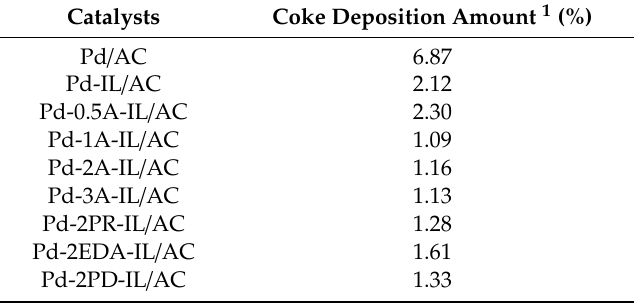
Figure 4. ( a , b ) TGA and DTG curves of the fresh and used Pd-2A-IL / AC catalysts. Table 4. Coke deposition amount on used Pd-based catalysts